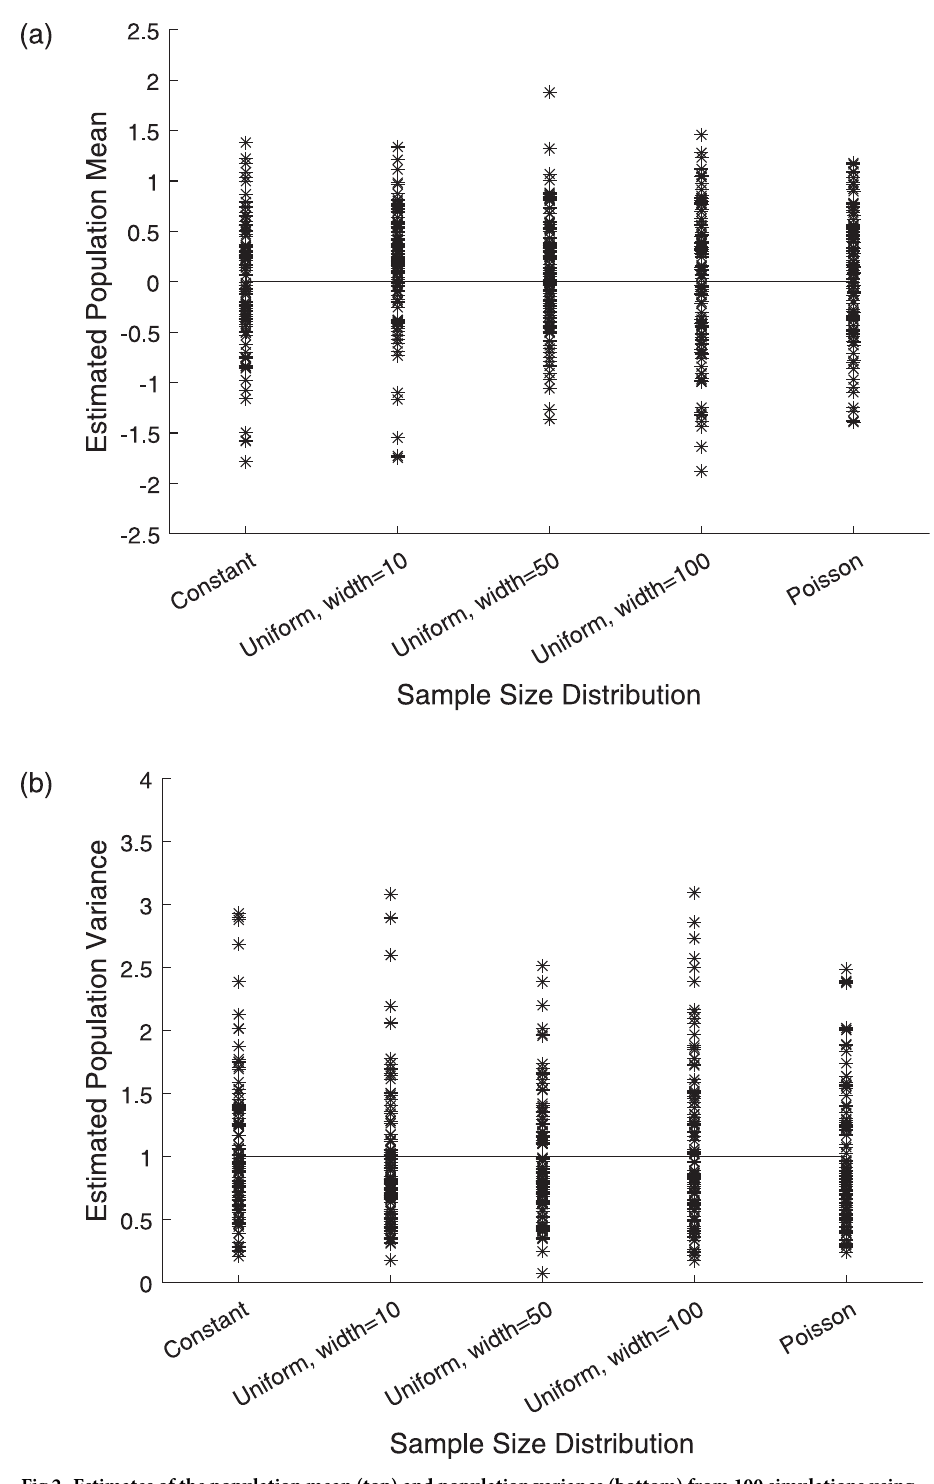
Fig 2. Estimates of the population mean (top) and population variance (bottom) from 100 simulations using m = 10 sample maxima. The maxima are computed over samples with average size E [ n j ] = 100 for various distributions of the n j .